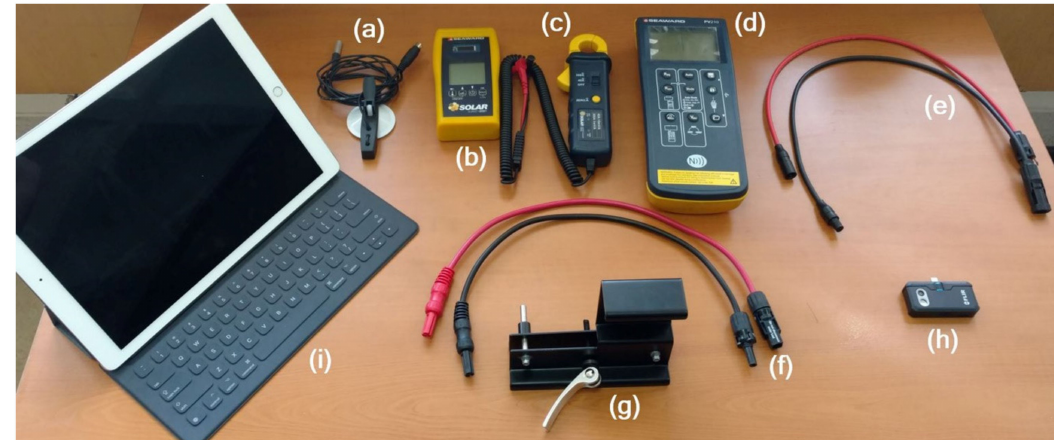
Figure 2. Minimum equipment and tools for data collection in the field. ( a ) Temperature sensors. ( b ) Irradiance sensors. ( c ) Direct current (DC clamp) ampere-meter. ( d ) Current-Voltage (IV) tracer. ( e ) MC3 to MC4 adapter leads. ( f ) MC4 tests leads. ( g ) Irradiance meter mounting bracket. ( h ) FLIR ONE pro camera. ( i ) iPad.